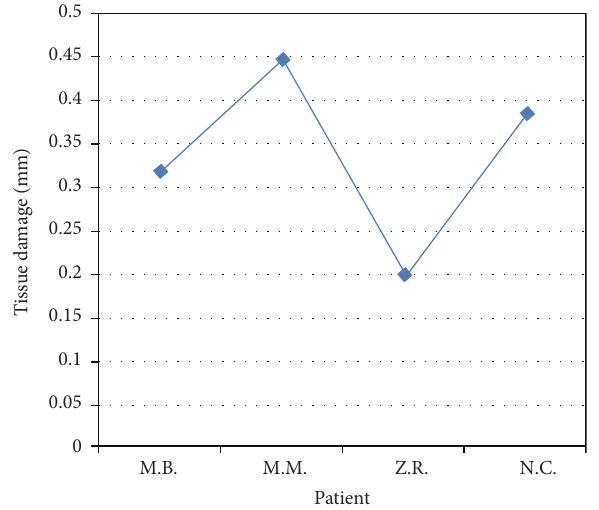
Figure 6: Peri-incisional marginal damage in hyperkeratotic lesion.